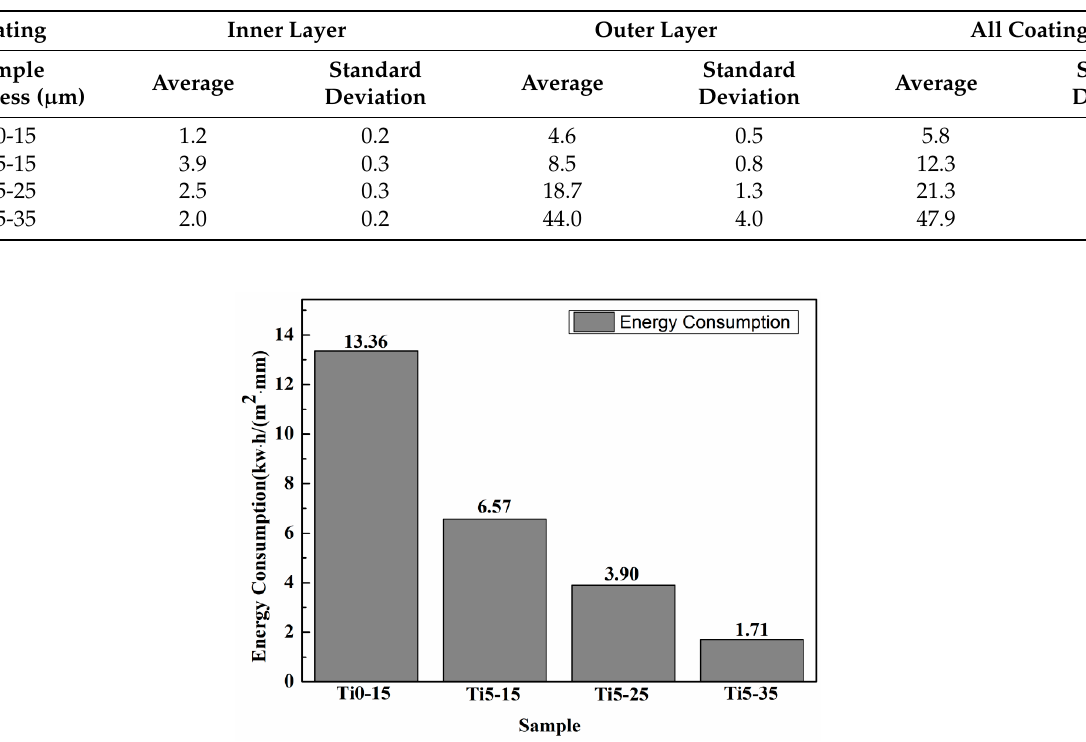
Table 4. Thickness of the MAO coating inner layer, outer layer and the whole coating of different samples after micro-arc oxidation for 10 min.